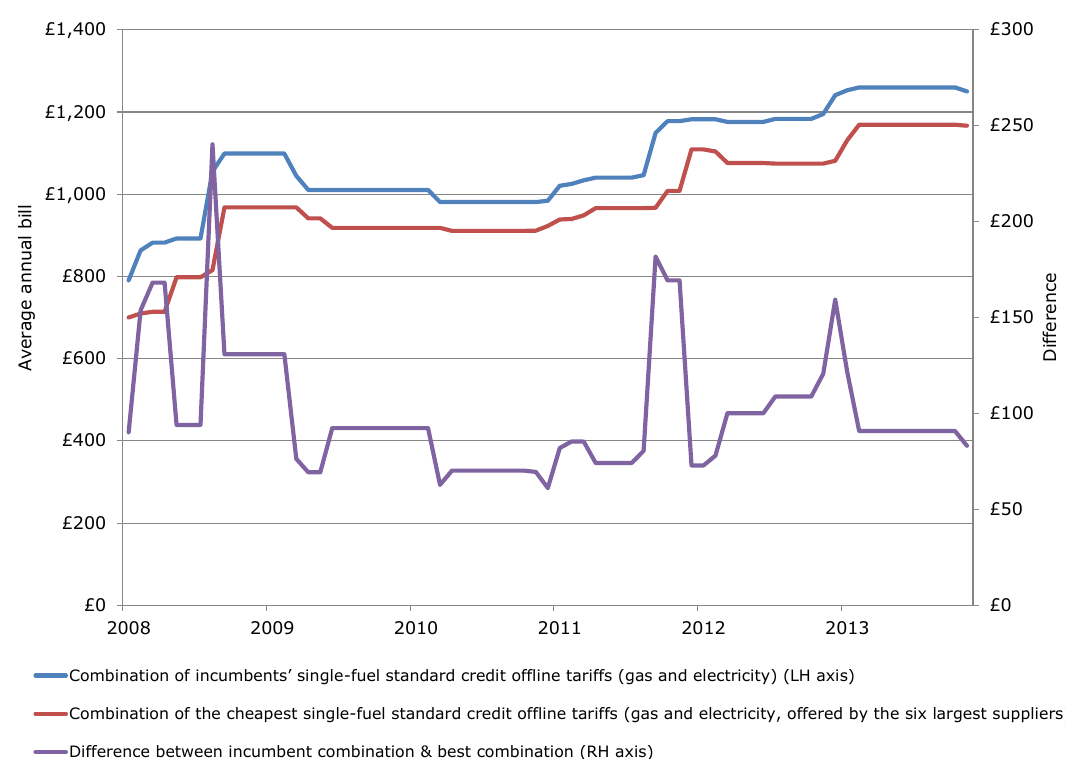
Figure 22: Incumbent tariffs (single-fuel electricity incumbent tariff + single-fuel gas incumbent tariff) compared against the sum of the cheapest single-fuel gas and electricity tariffs offered by the large incumbent suppliers